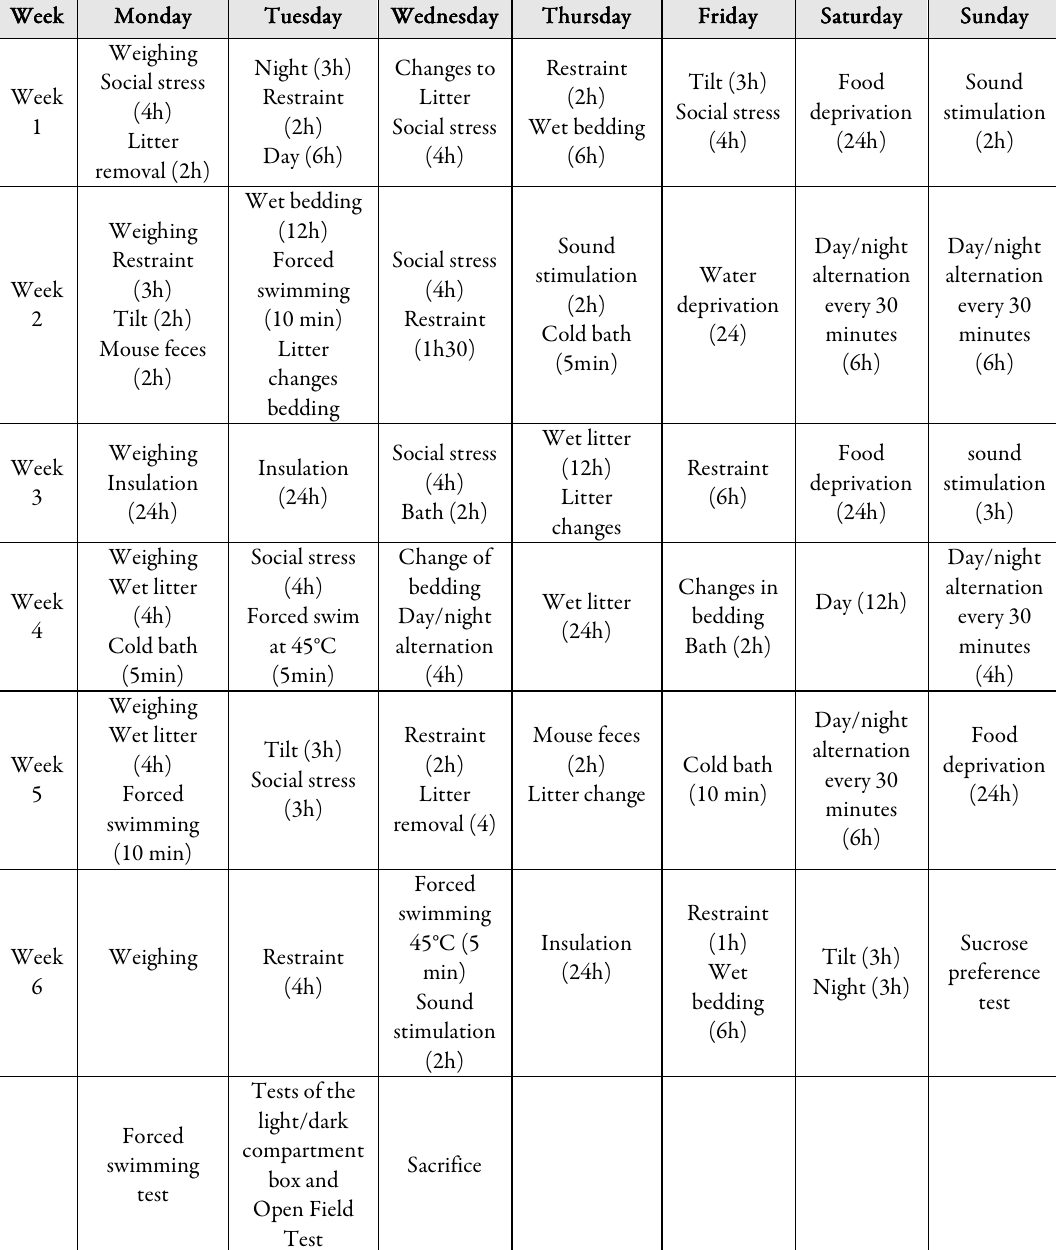
Table 1. Chronology of exposure to stressors and their